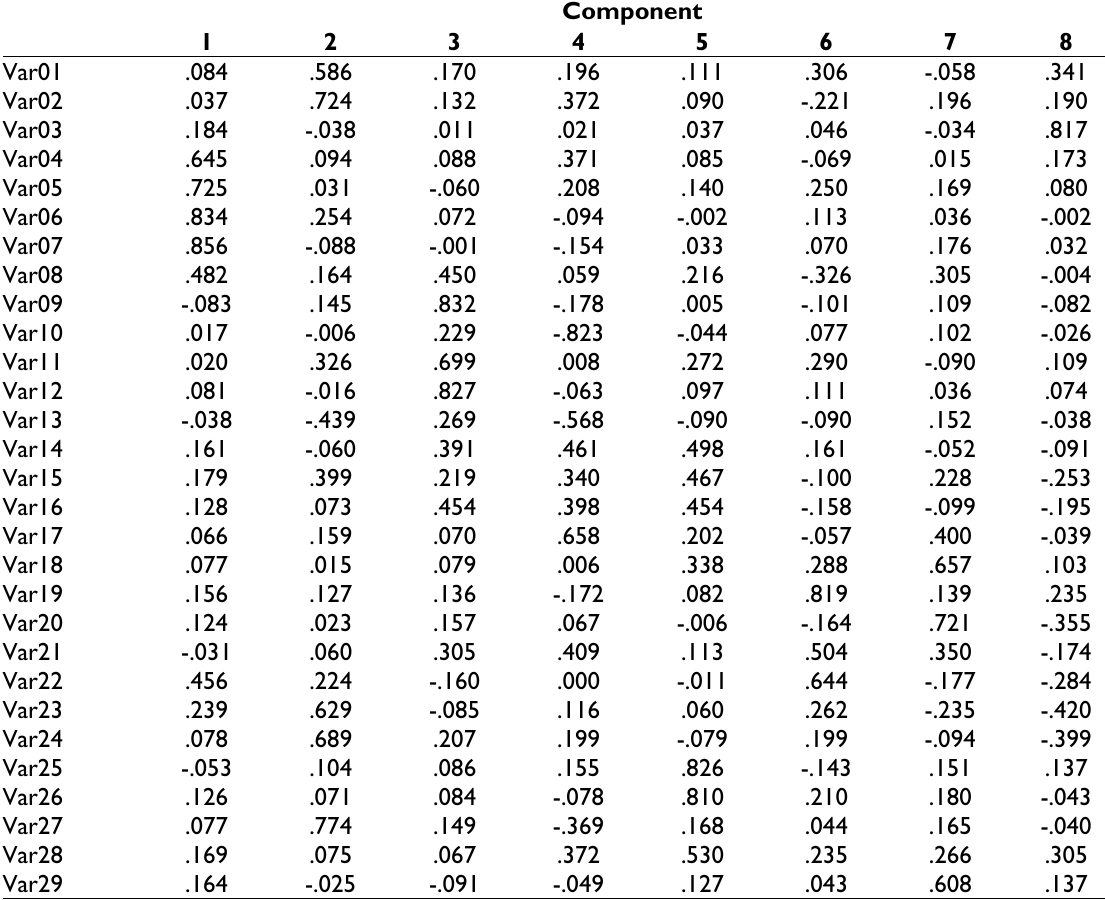
Table 3: Rotated Component Matrix